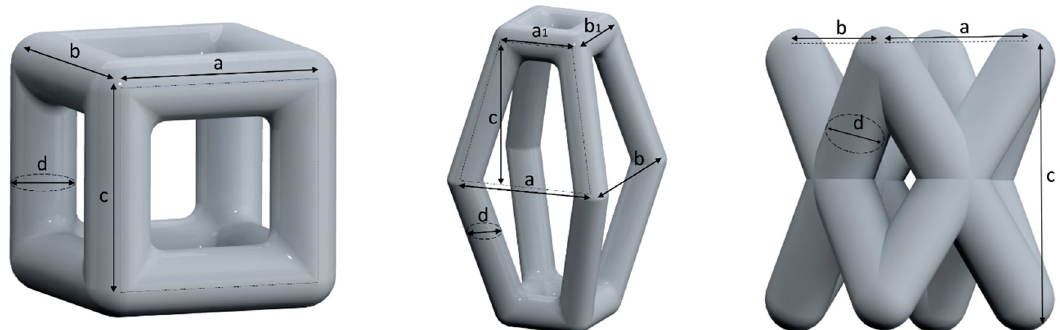
Figure 1. Structural composition of the three investigated designs: cubic ( left ), pyramidal ( middle ) and twisted ( right ). The geometrical parameters for the structures are height ( c ), width ( a ) and depth ( b ) of each unit structure. Struts from all designs had a circular cross ‐ section with the strut diameter ( d ). The pyramidal design had additional parameters a 1 and b 1 for width and depth of the smaller base and top surface, respectively.